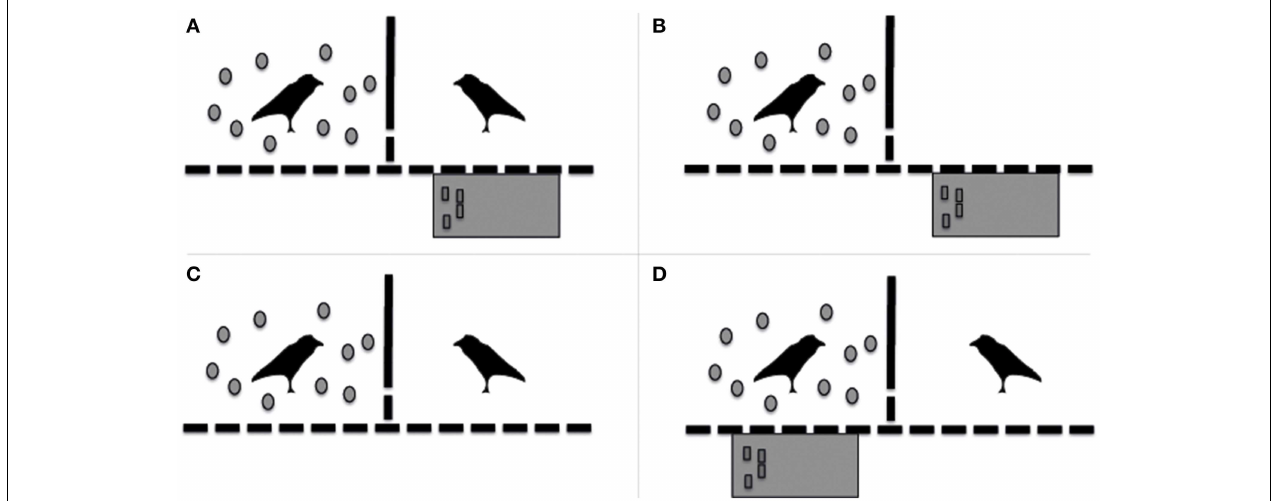
FIGURE 1 | Schematic representation of the different conditions in which the birds were tested in experiment 1. (A) Test condition; (B) Non-Social Control condition; (C) Social Control condition; (D) Motivation Control condition.